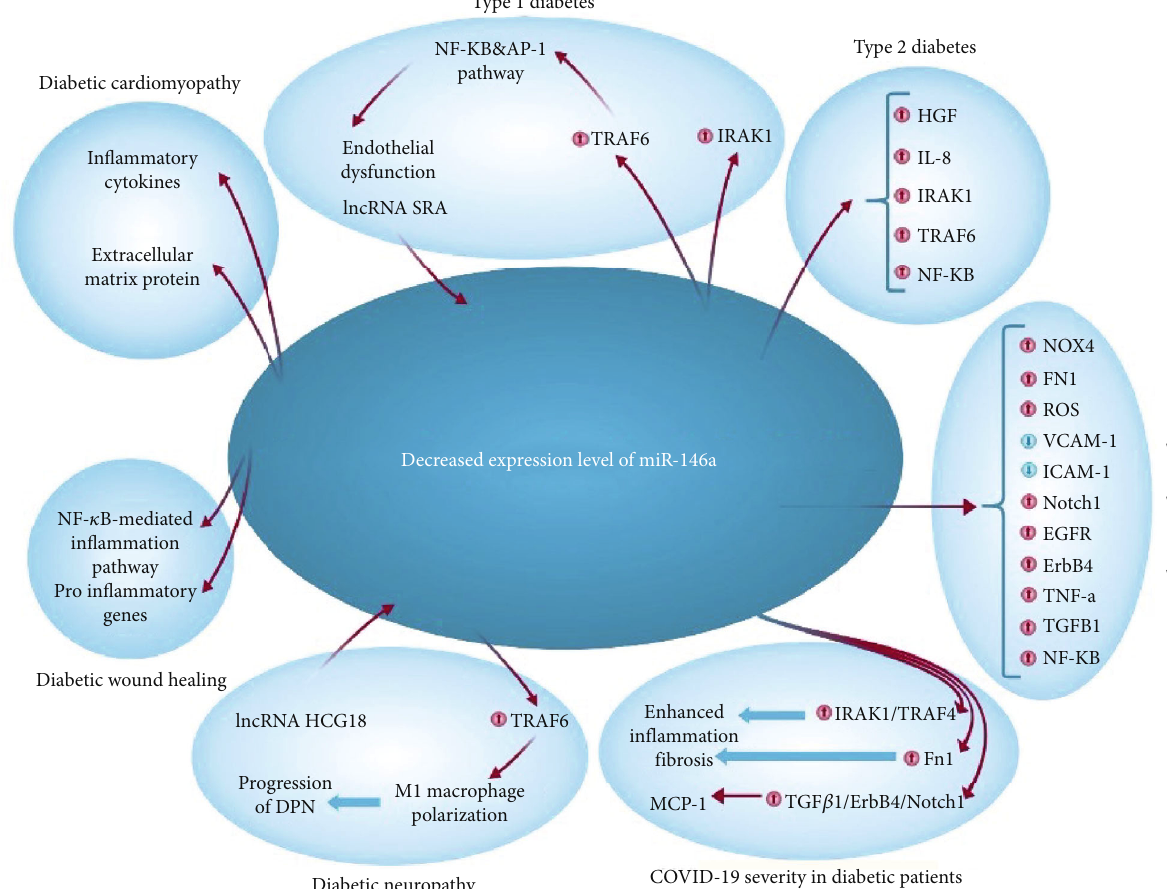
Figure 2: The decreased expression levels of miR-146a and its role in diabetes